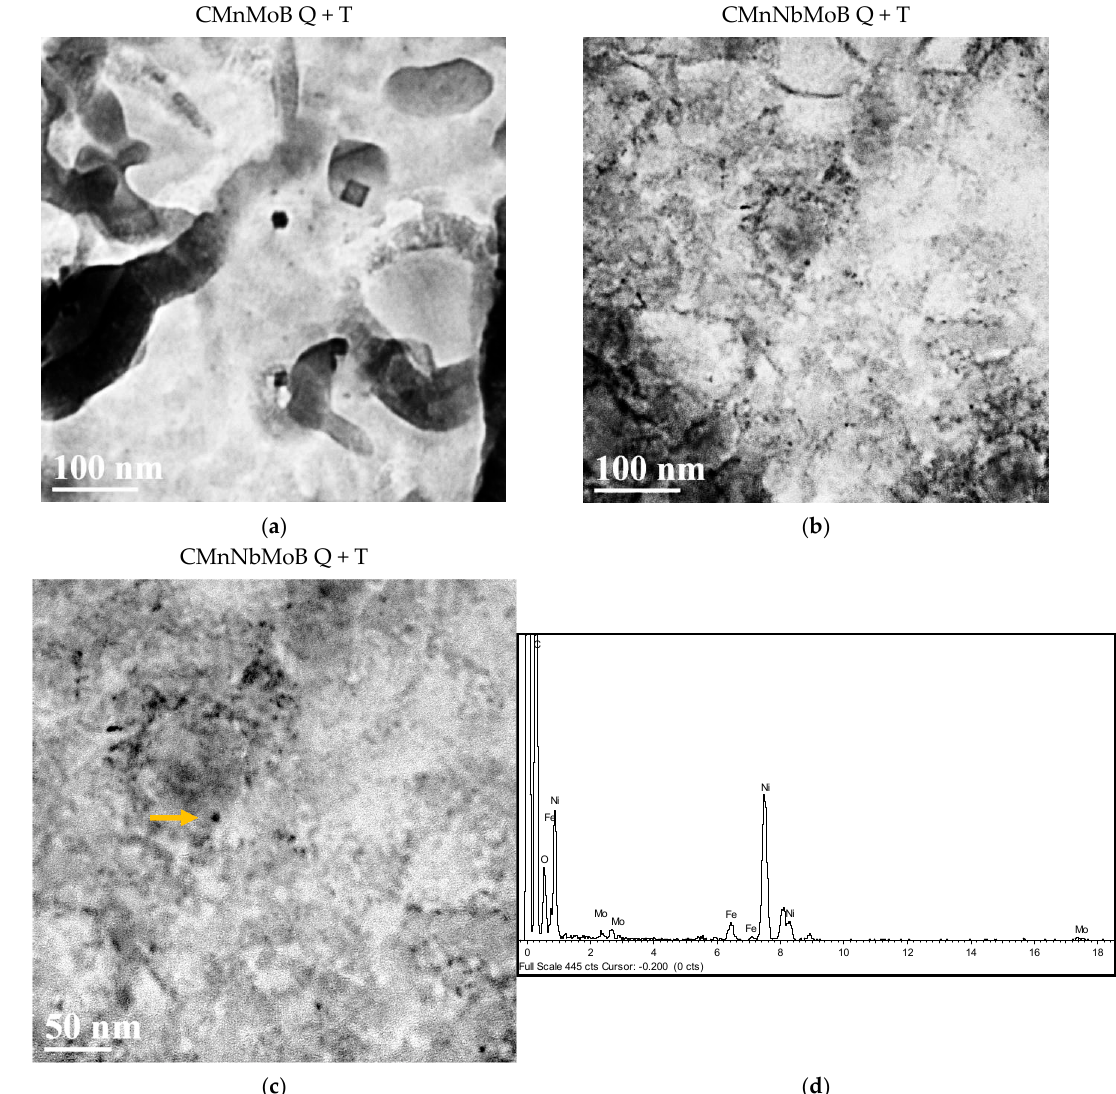
Figure 8. TEM micrographs corresponding to ( a ) CMnMoB and ( b , c ) CMnNbMoB grades and Q + T state ( d ) Microanalysis of the fine precipitate marked in ( c ) (the presence of Ni in the spectrum originates from the grid holding the carbon replica) .